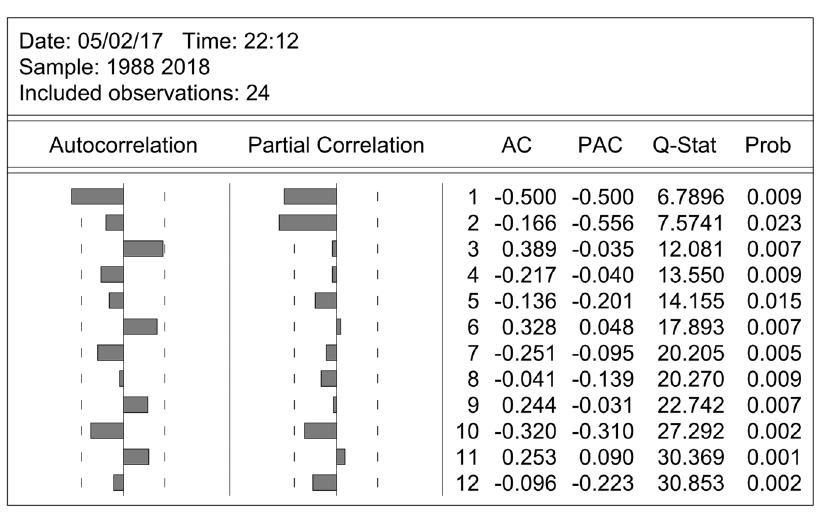
Figure 4. ACF, PACF and Q statistic of 1-order differencing sequence of